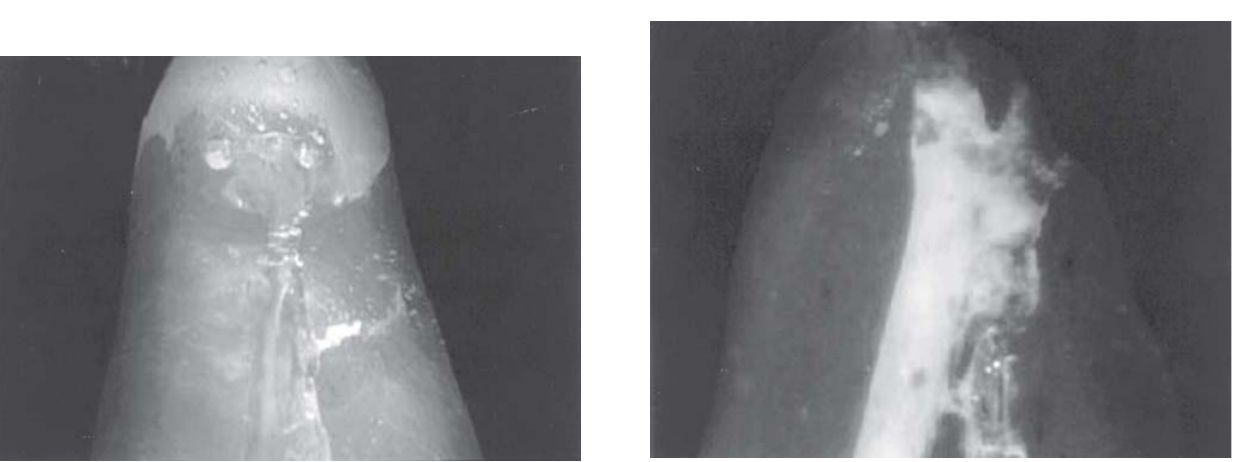
FIGURE 4- Example of score